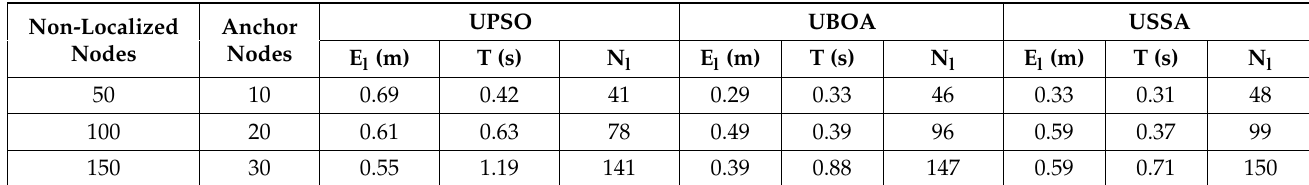
Table 3. Summary of experimental results of the various localization